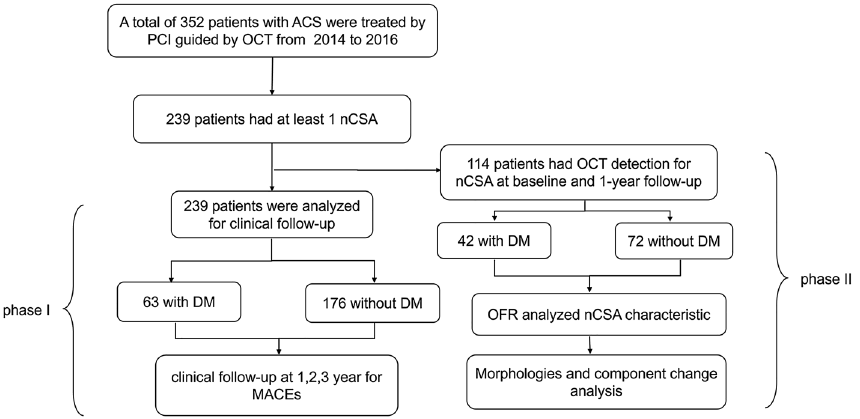
Figure 1. Study flow